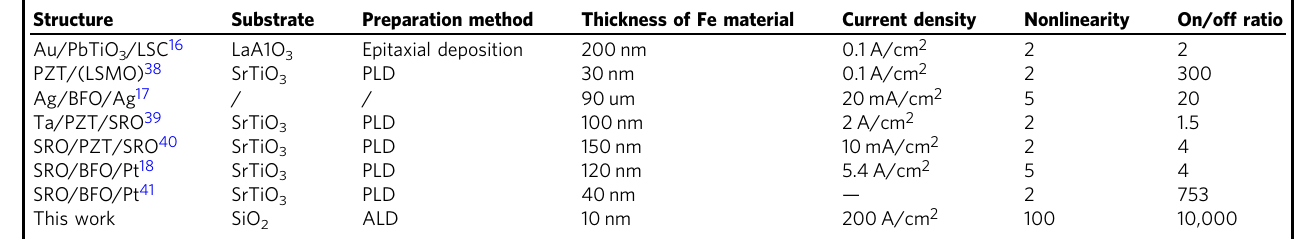
Table 1 Comparison of the various reported Fe-diode